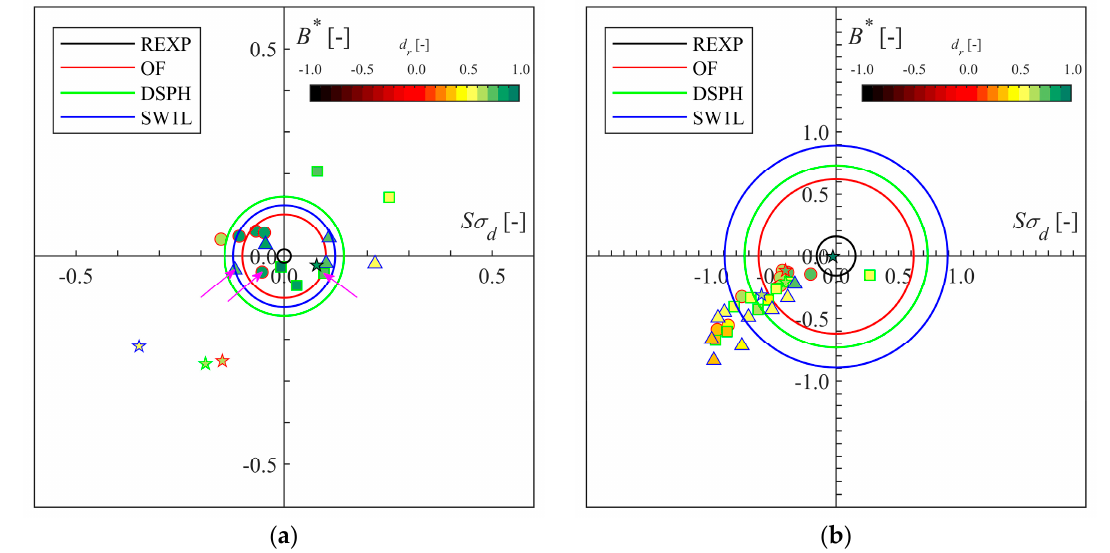
Figure 14. Numerical model skill target diagrams (target: EXP) for selected sensor locations along the flume. All markers are colour-filled according to the d r colour scale. The circles represent the mean value of all markers for a specific model. The data points of REXP are not plotted for clarity, but only the mean (black circle). ( a ) Target diagram with pattern statistics for η at locations WG04, 07, 13, 14 and averaged pattern statistics over WLDM01-WLDM04 for the promenade (OF: circles, DSPH: squares; and SW1L: triangles) and U x at the ECM location (pentagrams). The magenta arrows indicate the markers representing the model performance of η on the promenade (WLDM02). ( b ) p at approx. equidistant locations PS01, 03, 05, 07, 09, 10–13 (OF: circles, DSPH: squares; and SW1L: triangles) and F x (pentagrams). Note: the target diagrams have di ff erent axis